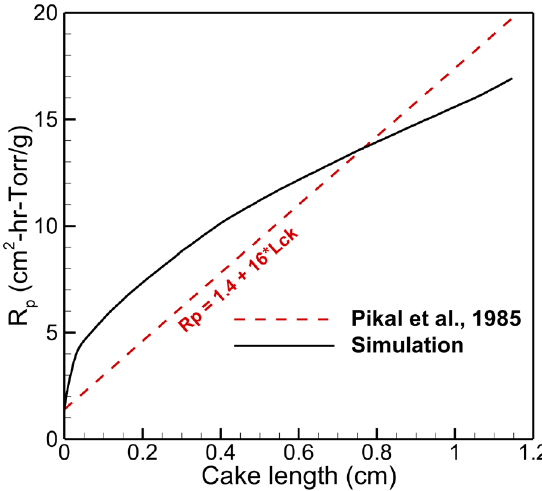
Figure 15. Product resistance calculated based on the simulation of primary drying stage of 4 ml 5% mannitol solution in 6R SCHOTT vials vs R p from Pikal et al. 41 .